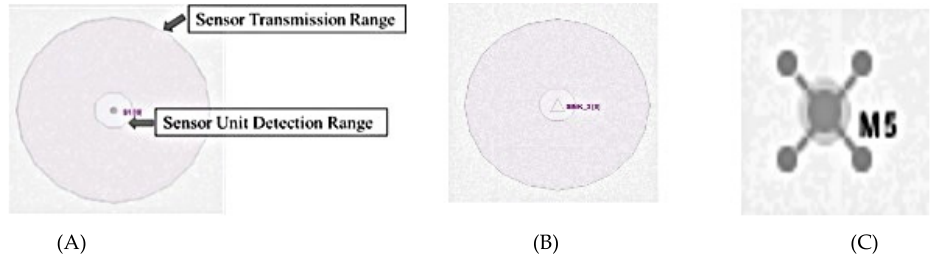
Figure 10. CupCarbon nodes ( A ); sensing node ( B ); base station (sink) node ( C ); mobile node.